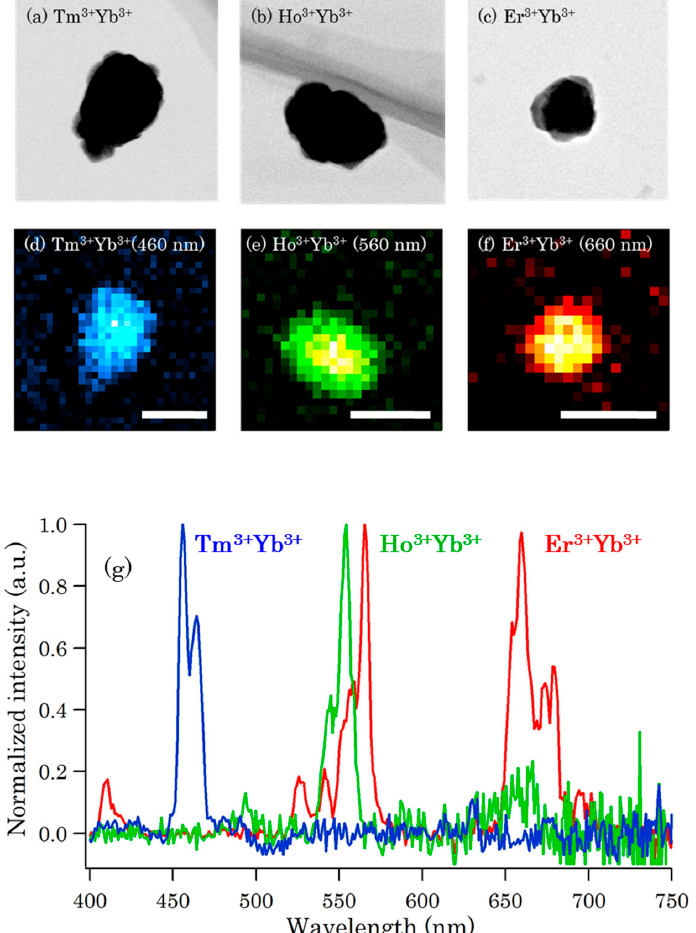
Figure 6. STEM images and CL images of Gd 2 O 3 co ‐ doped Tm 0.1 mol %/Yb 2 mol % ( a , d ); Ho 1 mol %/Yb 2 mol % ( b , e ) and Er 1 mol %/Yb 2 mol % ( c , f ) nanoparticles; ( g ) is the CL spectra of Gd 2 O 3 co ‐ doped Tm 0.1 mol %/Yb 2 mol% (blue); Ho 1 mol %/Yb 2 mol % (green) and Er 1 mol %/Yb 2 mol % (red). The scale bars are 100 nm.